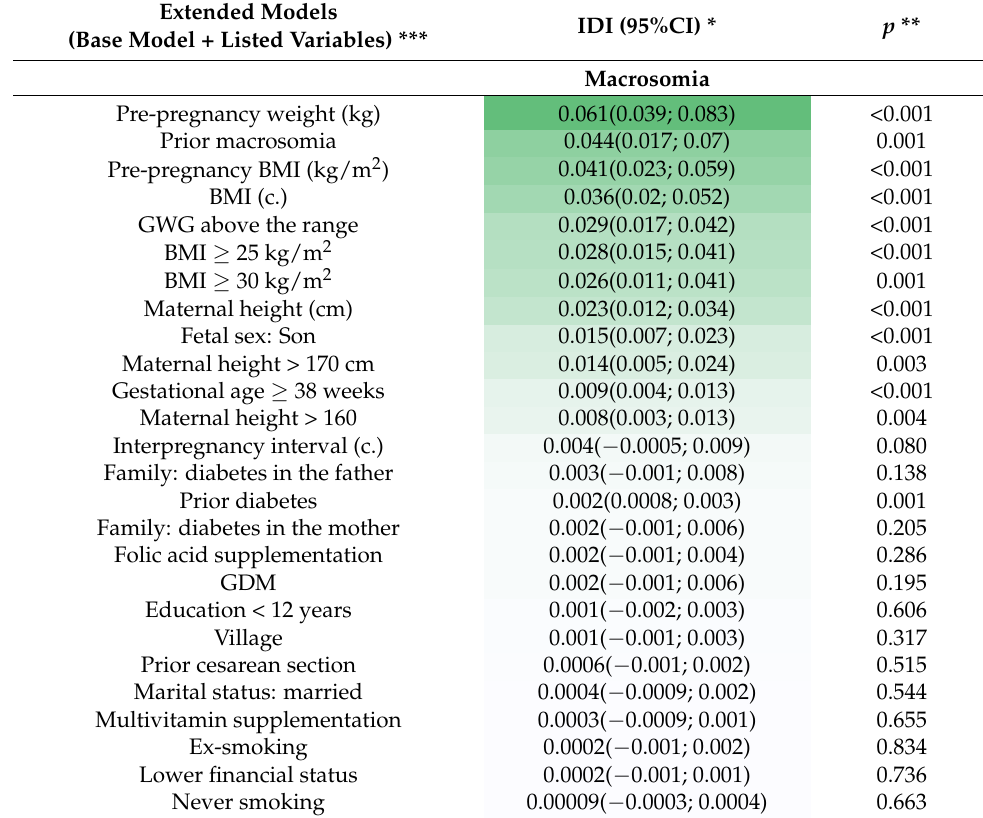
Table 4. Values of IDI in the extended multivariate models for the probability of macrosomia.